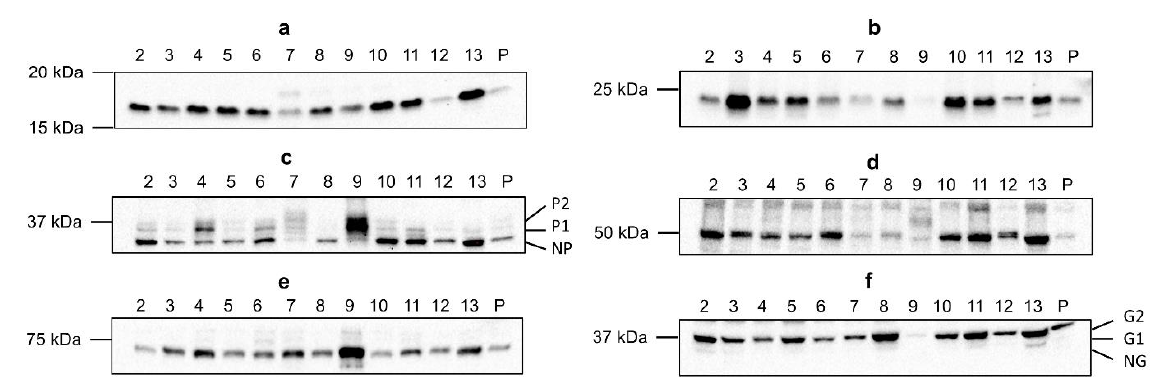
Figure 4: Cx26 (a), Cx32 (b), Cx43 (c), Panx1 (d), Panx2 (e) and Panx3 (f) protein expression in human liver disease. Total protein was extracted from the human liver biopsies (N = 70; n = 1) and used for immunoblotting analysis of all Cx and Panx protein targets. Immunoblots were visualized with a Pierce TM ECL Western Blotting Substrate kit (Thermo Fisher Scientific, USA) on a ChemiDoc TM MP imaging system (Bio-Rad, USA). A representative blot per protein target is shown. Sample numbers are indicated above the blot. (P, pooled sample; P1 and P2, phosphorylated isoforms; NP, non-phosphory- lated isoform; G1 and G2, glycosylated isoforms; NG, non-glycosylated isoform)